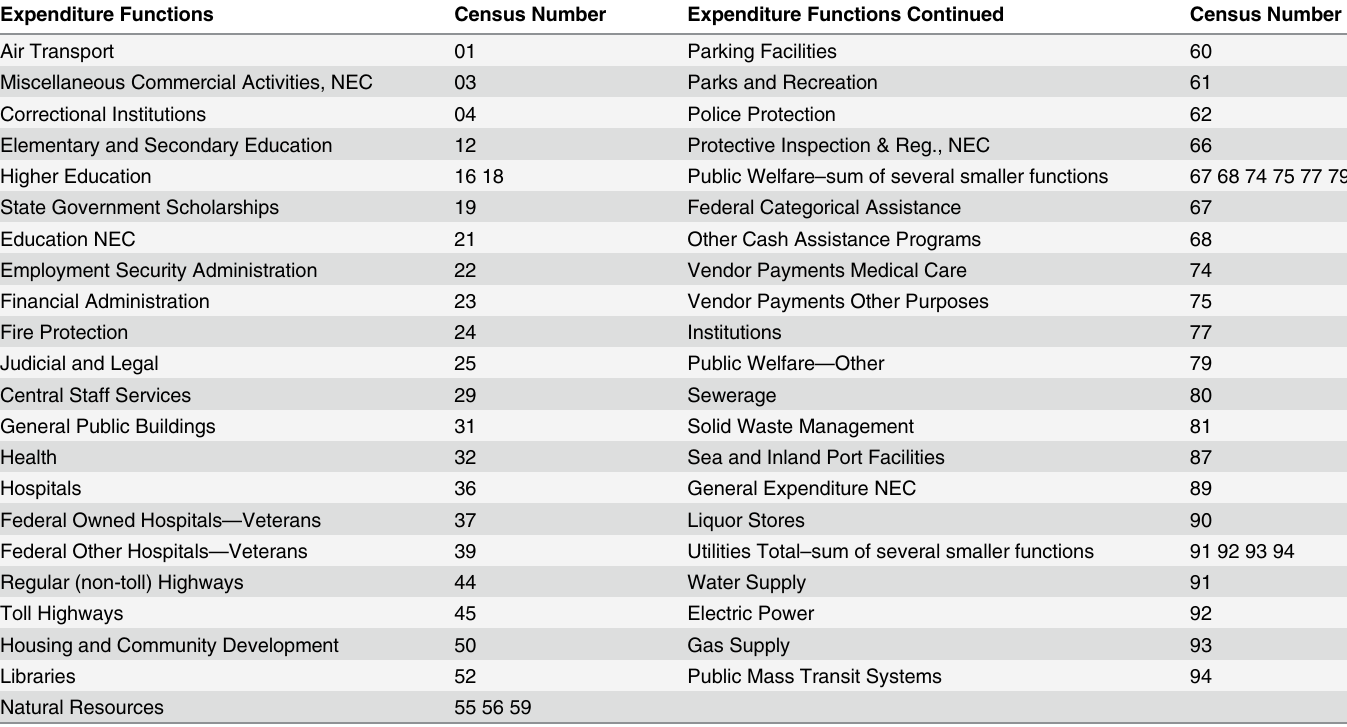
Table 8. Expenditure Function